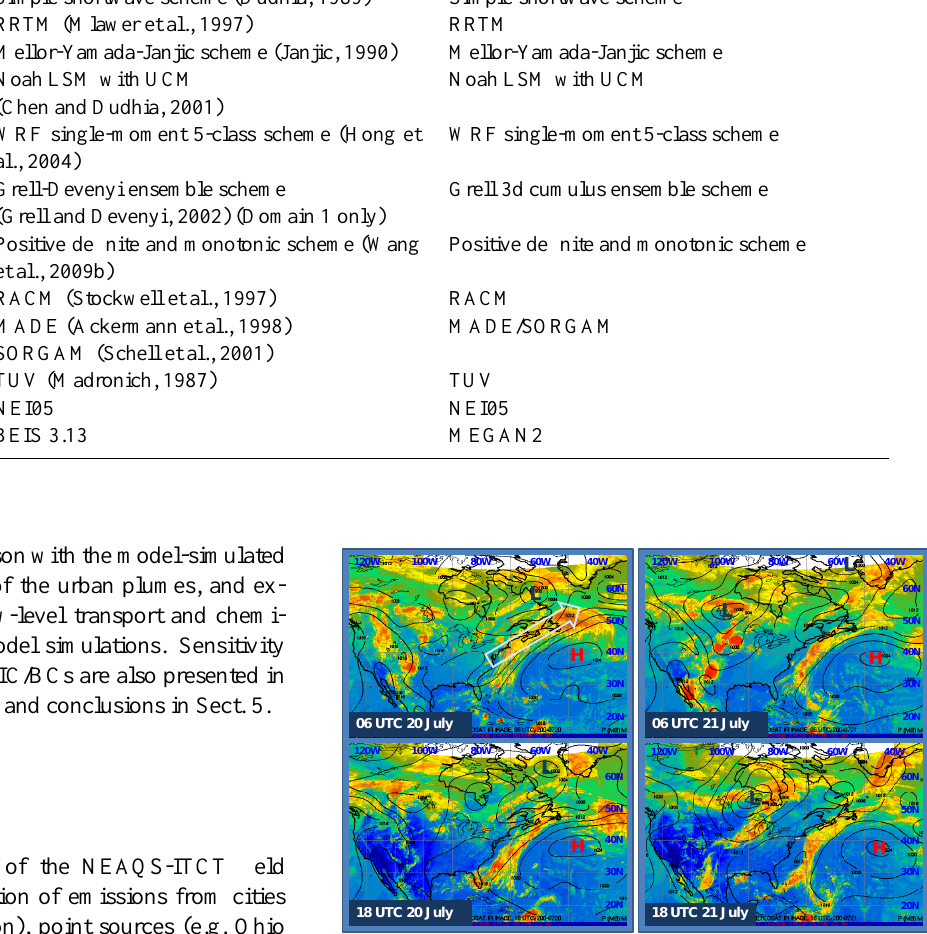
Fig. 1. Infrared images combined from GOES-WEST, GOES- EAST, and METEOSAT-7 geostationary satellites over North America and the North Atlantic Ocean on 20 and 21 July with a 12-h interval. Contours indicate mean sea level pressure in hPa. A white arrow indicates an export pathway of the North America pollutants in association with transient mid-latitude cyclones and a stationary maritime high pressure system in the North Atlantic Ocean.